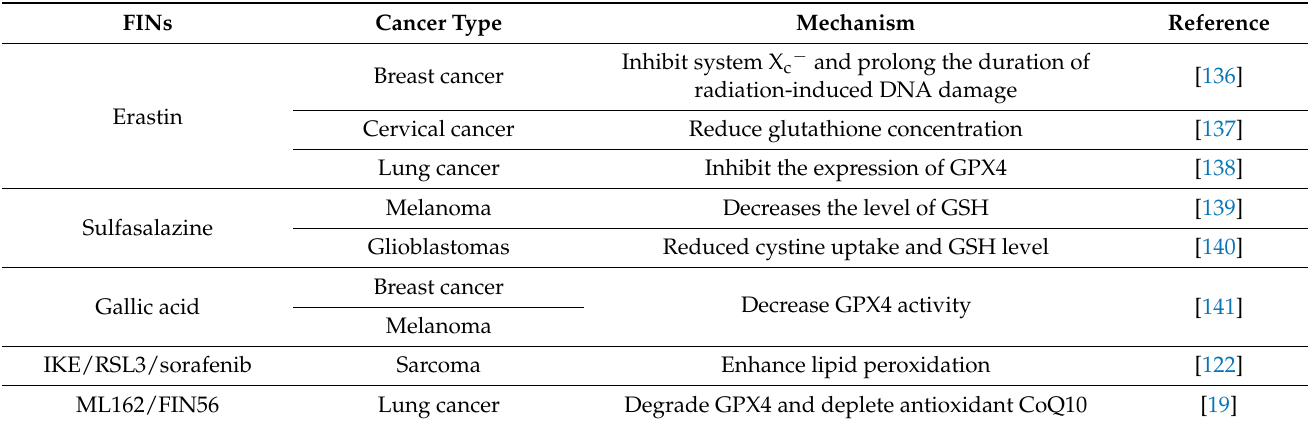
Table 1. Radiosensitizing effect of ferroptosis inducers on tumor cells.